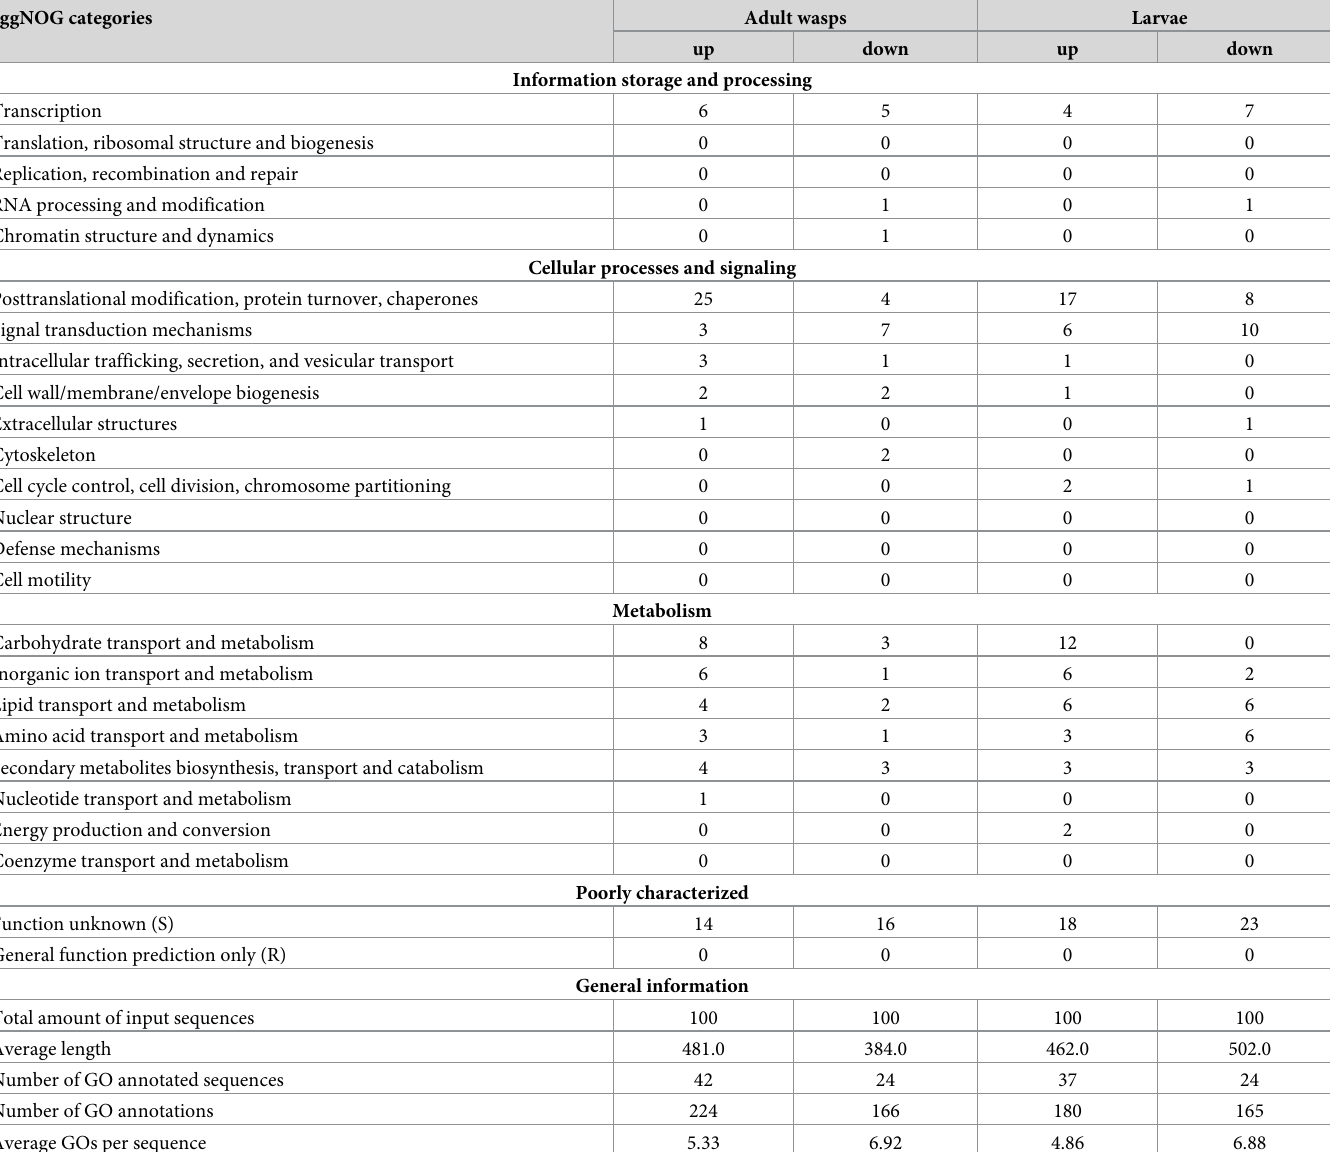
Table 8. EggNOG results on the orthology relationships, gene evolutionary histories and functional annotations of the top 100 gut-biased DEGs found in the tran- scriptome of A . compressa . eggNOG